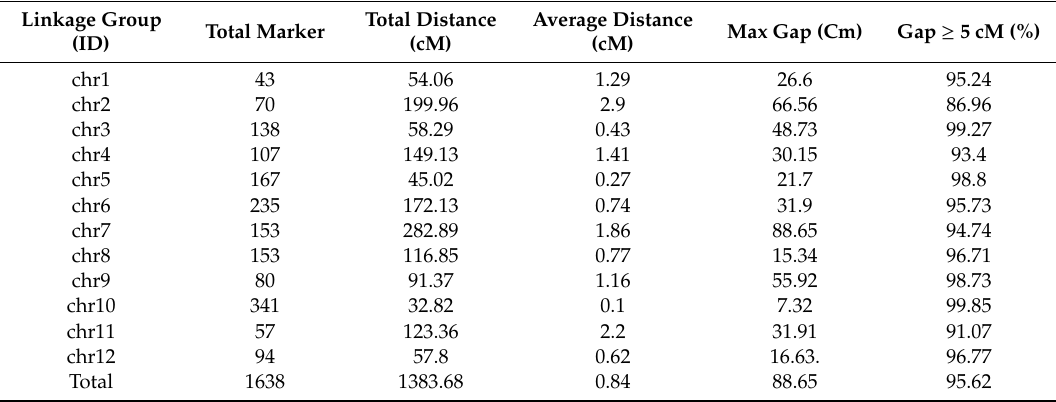
Table A1. The maternal genetic map for tetraploid